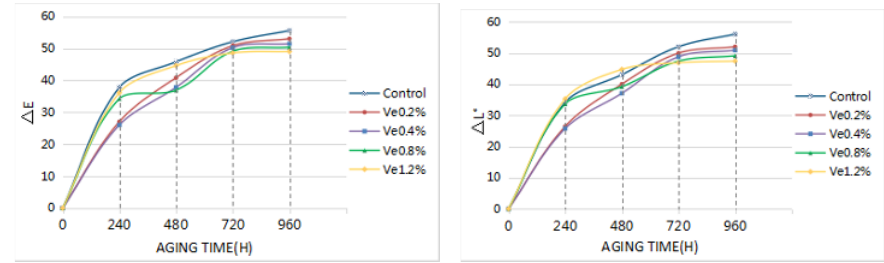
∗ ∆ L ） difference and color （ E ∆ ） difference during aging